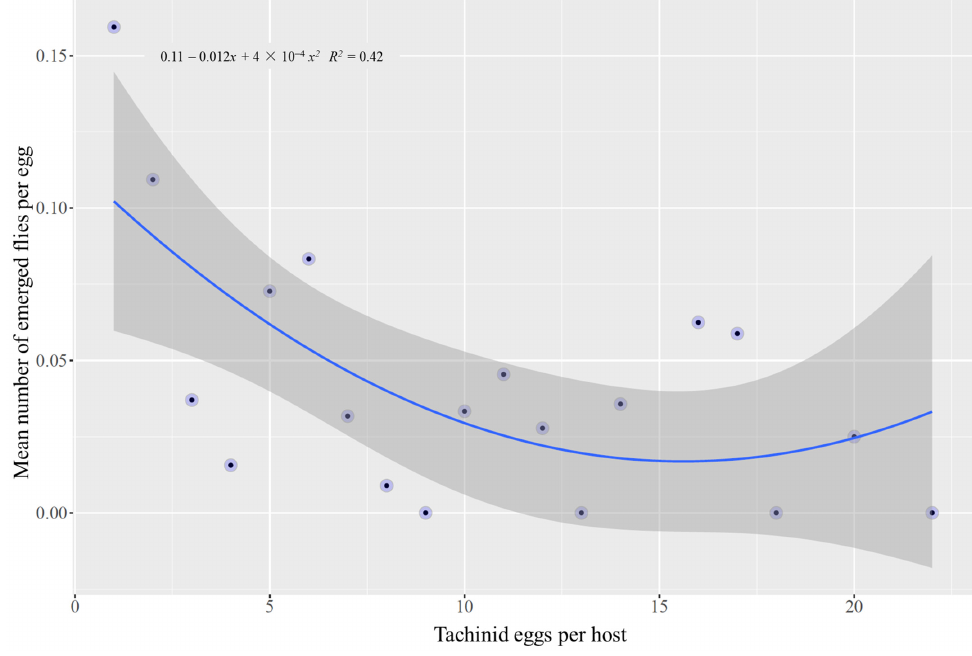
Figure 6. Relationship between the mean number of tachinid flies in response to the number of eggs per host.